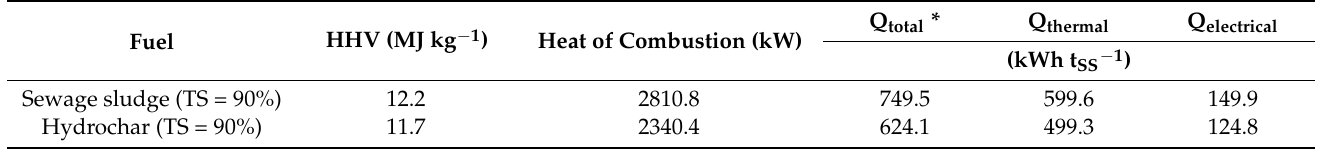
Table 8. Comparison of the potential energetic use of dried sewage sludge and hydrochar (both at 90% TS ) in a combined heat and power plant.